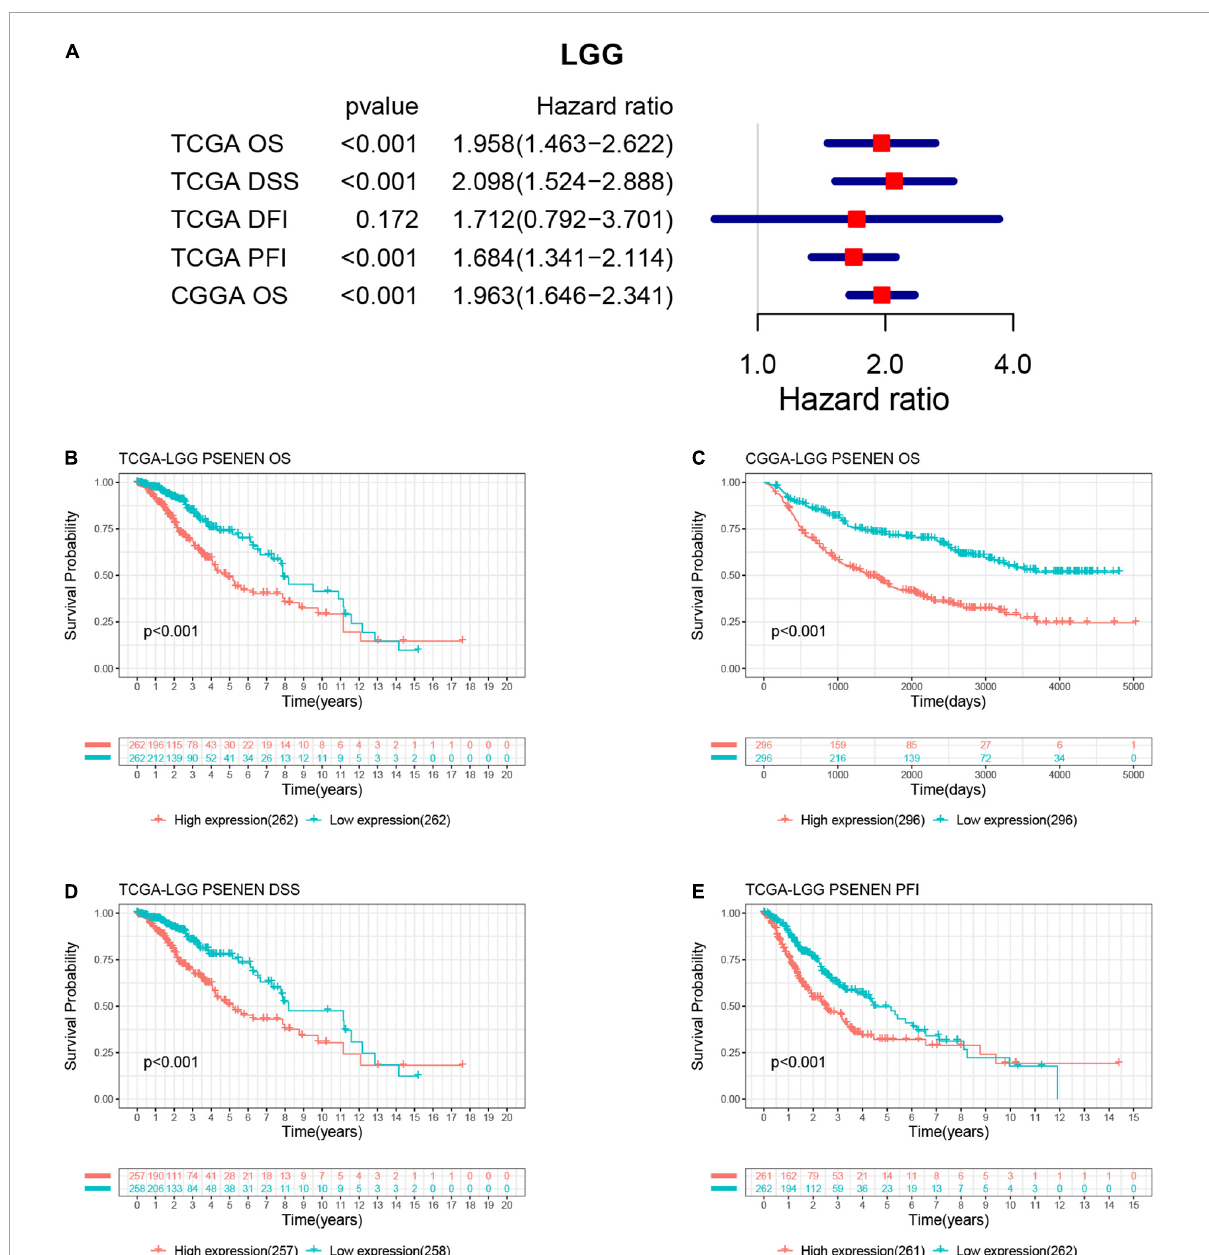
FIGURE2 Associations between PSENEN expression levels and the survival prognosis of patients with LGG. (A) Forest plot showing the hazard ratios of PSENEN in LGG. Kaplan—Meier survival curves of OS (B,C) , DSS (D), and PFI (E) for patients stratified according to PSENEN expression profiles in